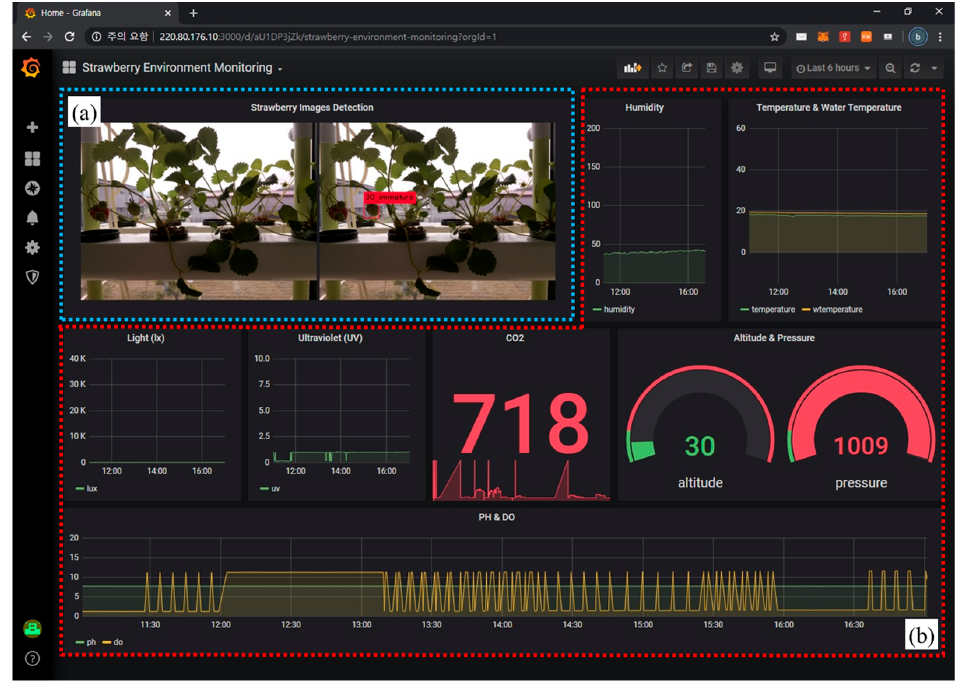
Figure 9. Visualization of the strawberry environment monitoring and the harvest decision.